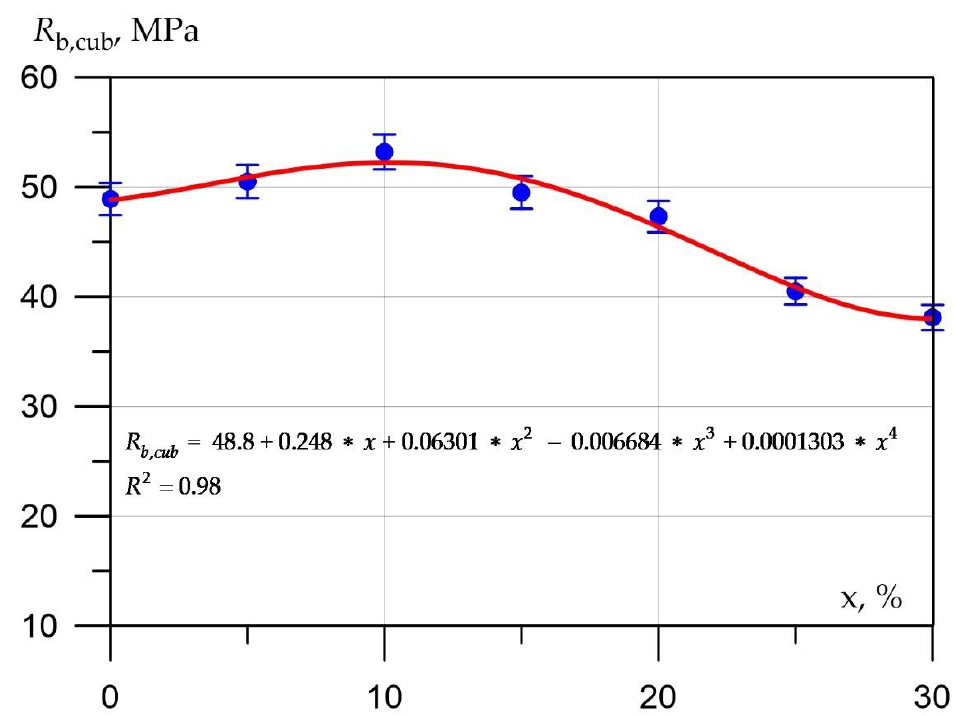
Figure 2. Dependence of the compressive strength of concrete on the amount of eggshell powder.